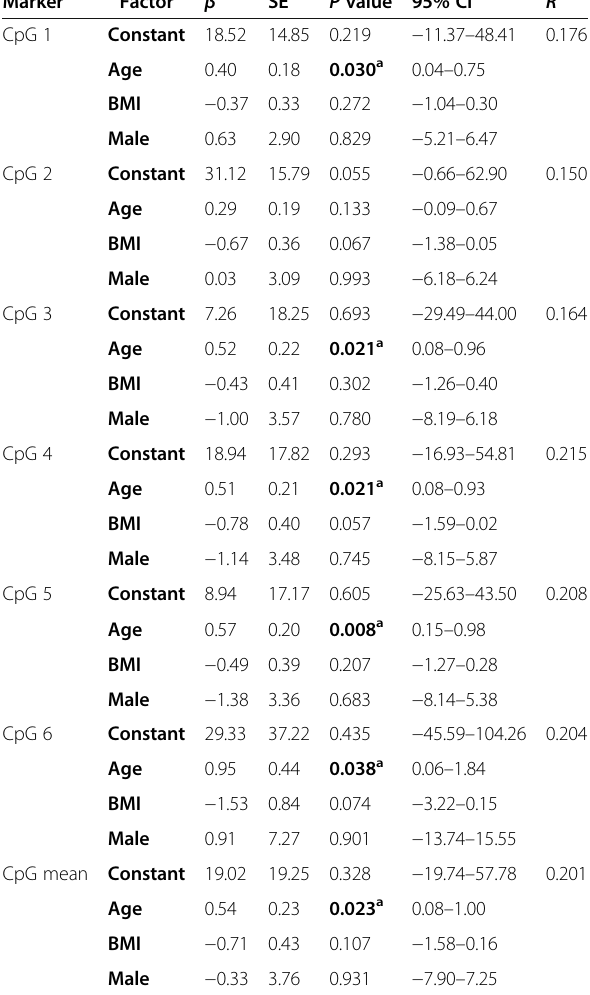
Table 5 Linear regression for factors affecting methylation in the controls